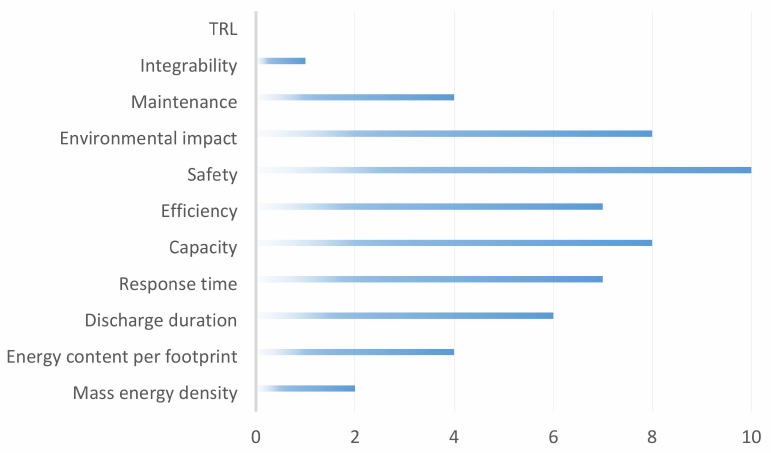
Figure 10. KPIs’ comparative ranking for scenario